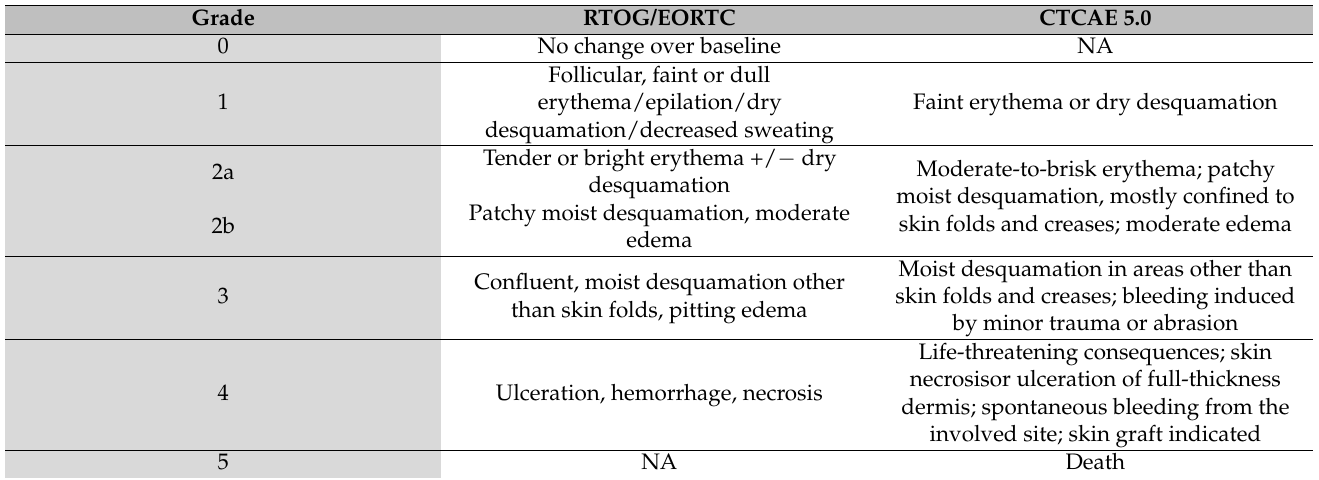
Table 1. The classification of acute radiation